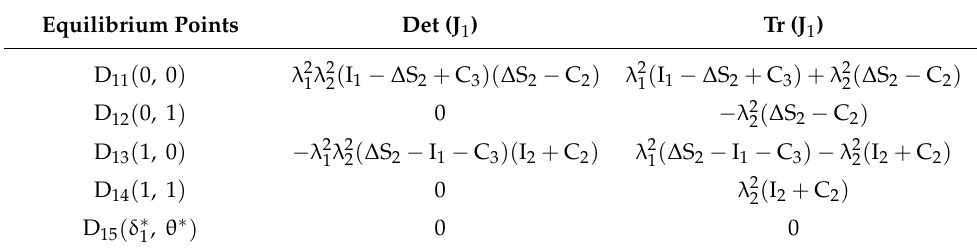
Table 3. Determinants and traces of equilibrium points under litigation settlement. Equilibrium